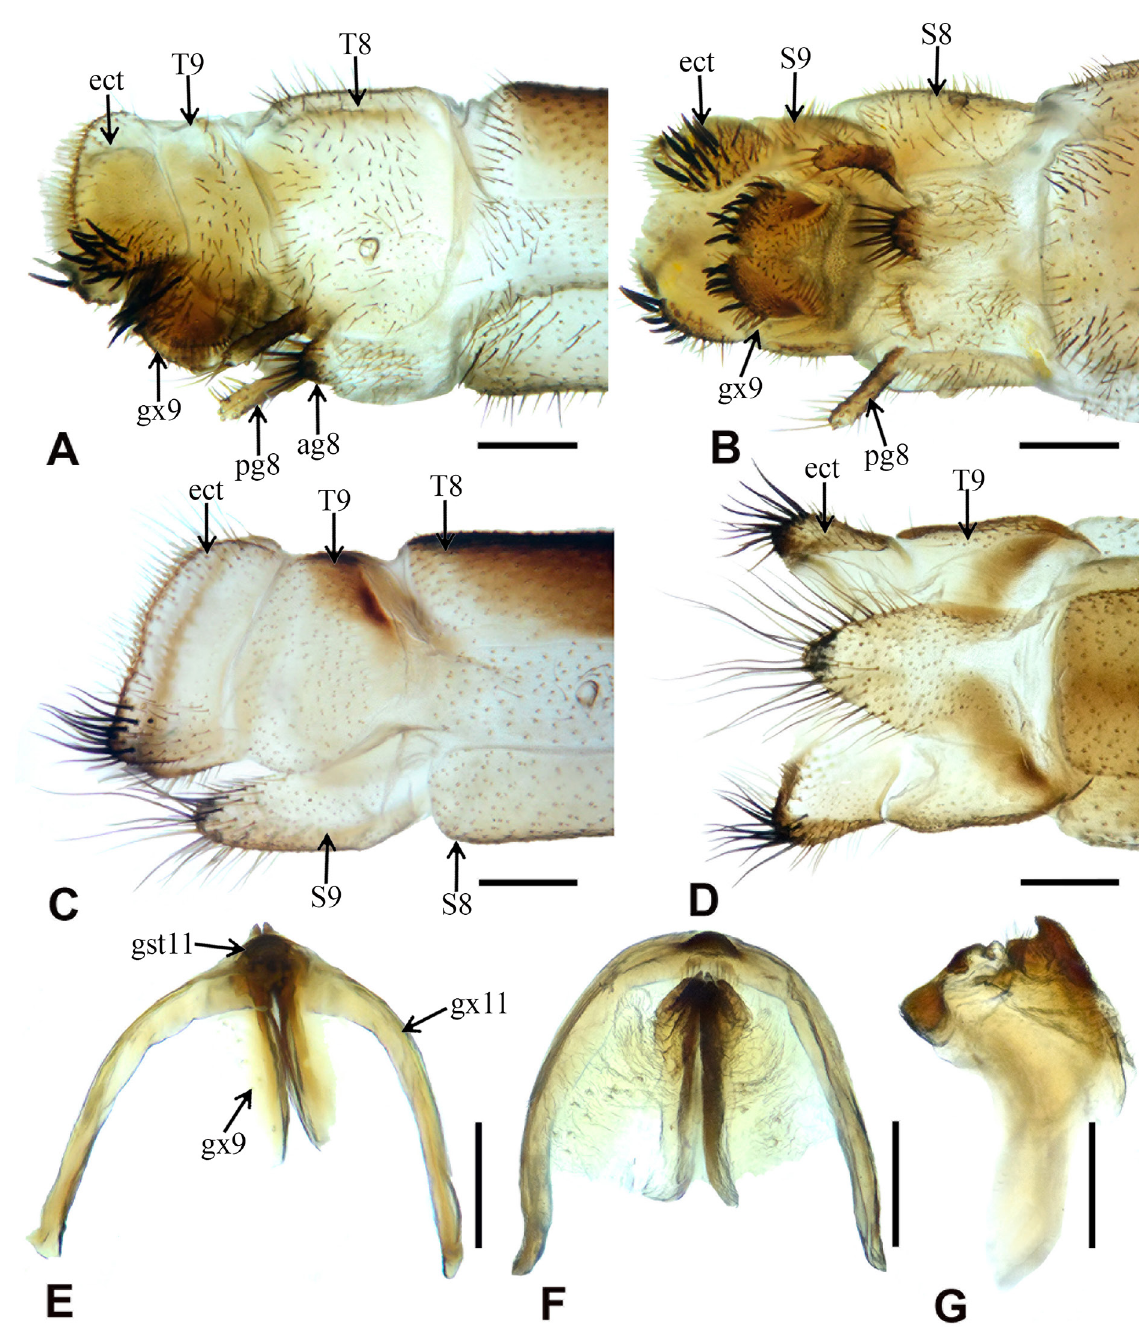
Fig. 4. Baliga kashmirensis sp. nov. A . Female genitalia, lateral view. B . Same, ventral view. C . Male genitalia, lateral view. D . Same, ventral view. E . Complex of gonocoxites 9 + gonocoxites 11, dorsal view. F . Same, ventral view. G . Same, lateral view. Abbreviations: ag8 = anterior gonocoxites 8; ect = ectoproct; gst11 = gonostylus 11; gx9 = gonocoxites 9; gx11 = gonocoxites 11; pg8 = posterior gonocoxites 8; pp = pregenital plate; S = sternites; T = tergites. A–B: ♂ (CAUPK00002); C–G: ♀ (CAUPK00001). Scale bars = 0.5